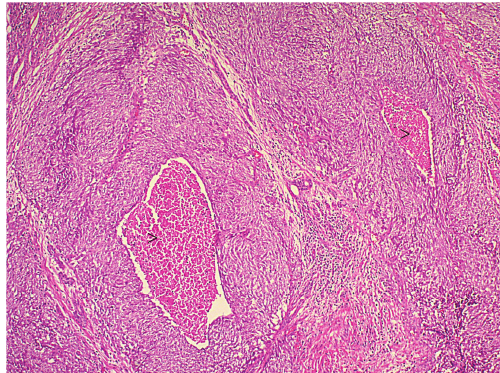
Figure 2: Low-magnification view of representative histopathology field of the lesion. Tumor shows epithelioid and spindled cells with central zone of necrosis (Arrow heads). (H&E